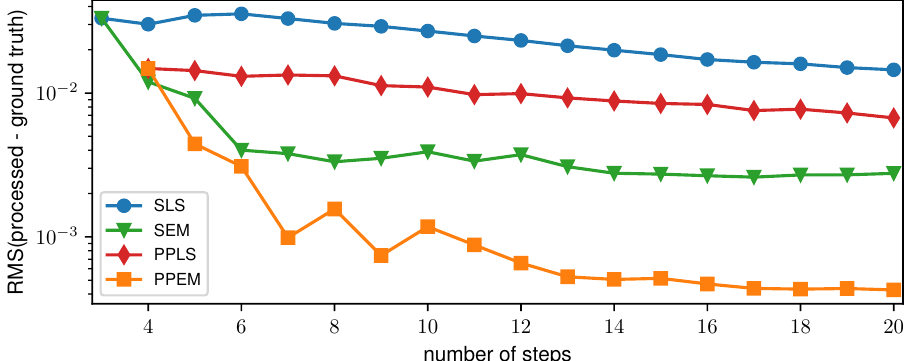
Figure 6. Root-mean-square (RMS) of the difference between the processed and ground truth differential-phase contrast images of the 2-grating interferometer over the number of phase steps for all four processing